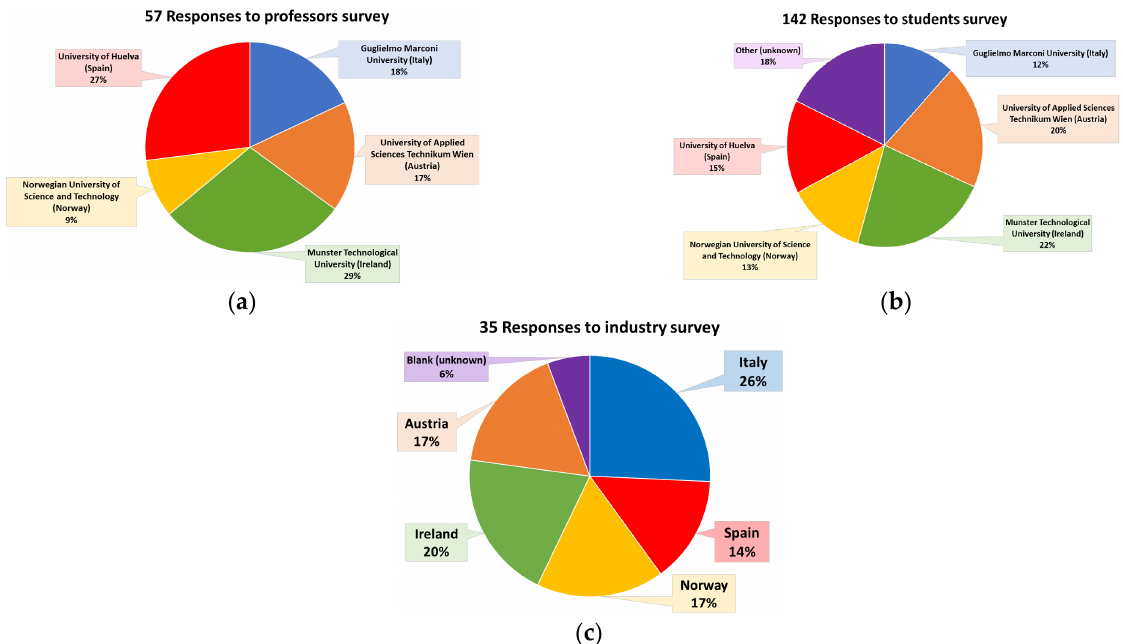
Figure 3. Survey data collection: ( a ) Responses to professors’ survey; ( b ) Responses to students survey; ( c ) Responses to industry survey.